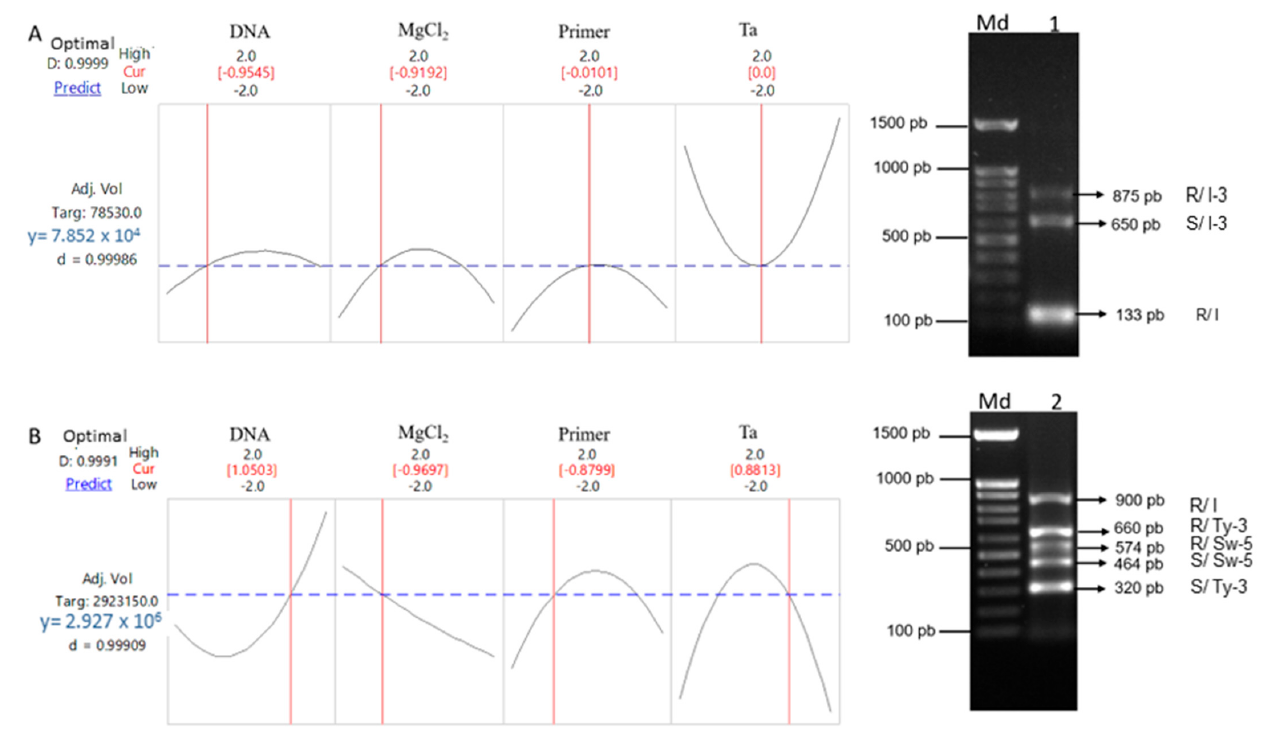
Figure 3. Desirability function plots of optimized PCR for molecular markers ( A ) At–2, and P7–43, ( B ) SSR–67, Sw–5 and P6–25. Md, 100 bp molecular weight marker. R indicates resistant genotype and S indicates susceptible genotype. The 1 indicates protocol 1 and 2 indicates protocol 2.